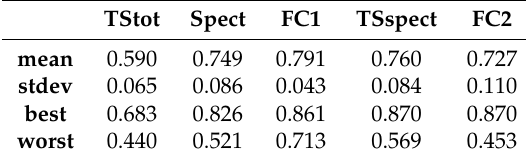
Table A1. Accuracy for wideband excitation (150kHz to 20kHz). Compare also Figure 7a.